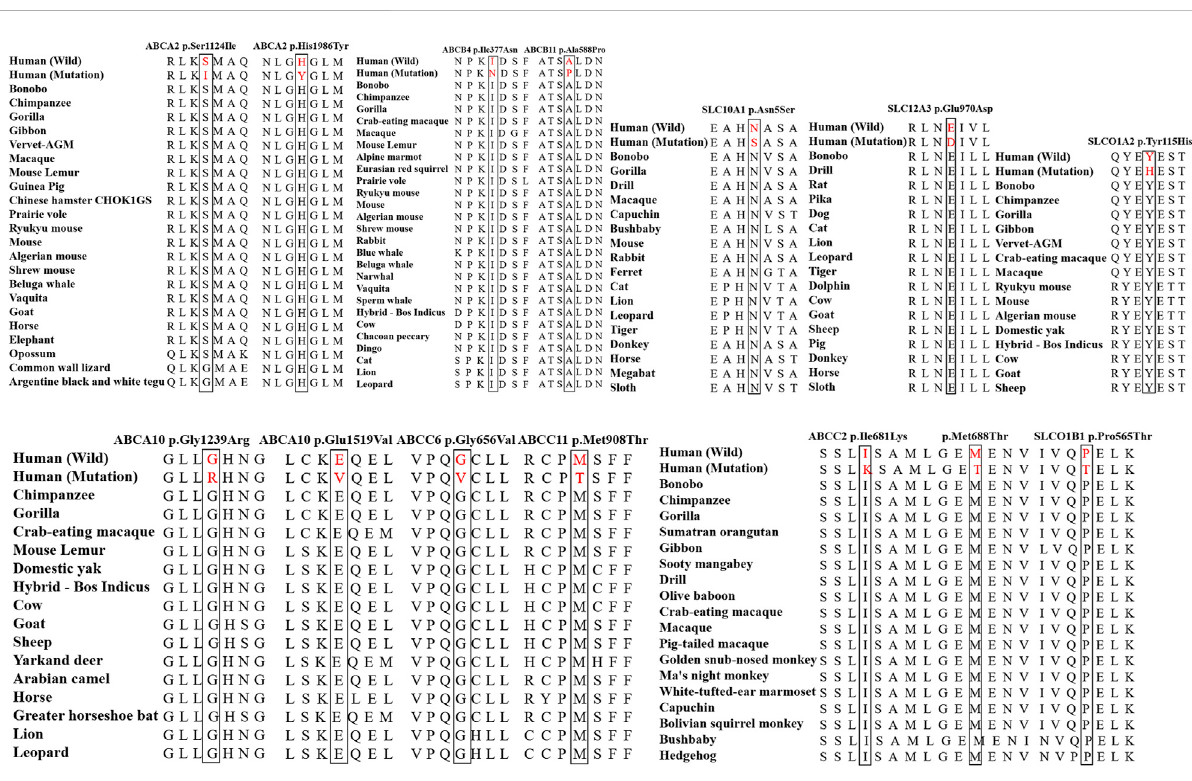
Table S2) that were associated with bile acid transporters and